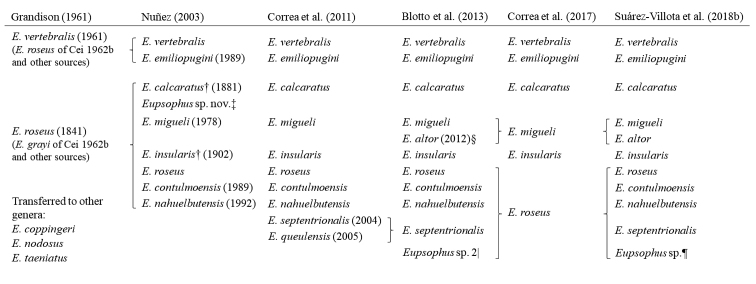
Composition of the genus Eupsophus between 1961 and 2018 according to several reviews and studies. Year of species description is provided in parentheses. Capurro (1958) and Cei (1958, 1960, 1962a, 1962b) recognized the same two species of Grandison (1961), but with different names (see comment in Cei 1962b). †Revalidated by Formas and Vera (1982) (removed from the synonymy of E.roseus). ‡Undescribed species from Isla Wellington (Chile), sister to E.calcaratus. §It appears as Eupsophus sp. 1 in Blotto et al. (2013). |Probable undescribed species from Tolhuaca (Chile), sister to E.roseus. ¶Putative species from Villarrica (Chile), sister to E.roseus.